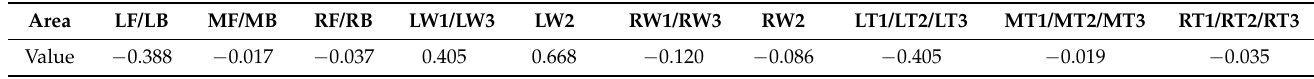
Table 7. Distribution coefficient of wind pressure on each surface when the shed azimuth angle in the plain area is 90 ◦